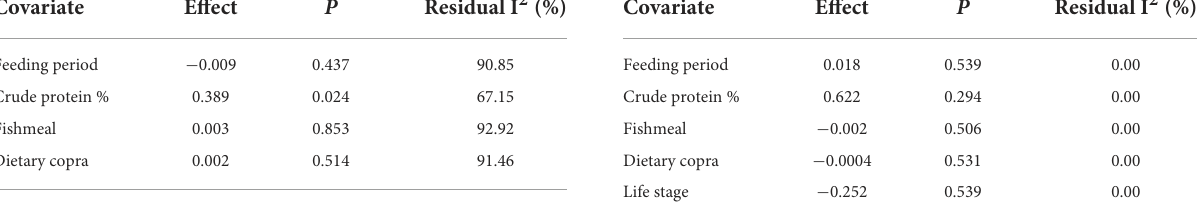
TABLE 6 Meta-regression for PER.